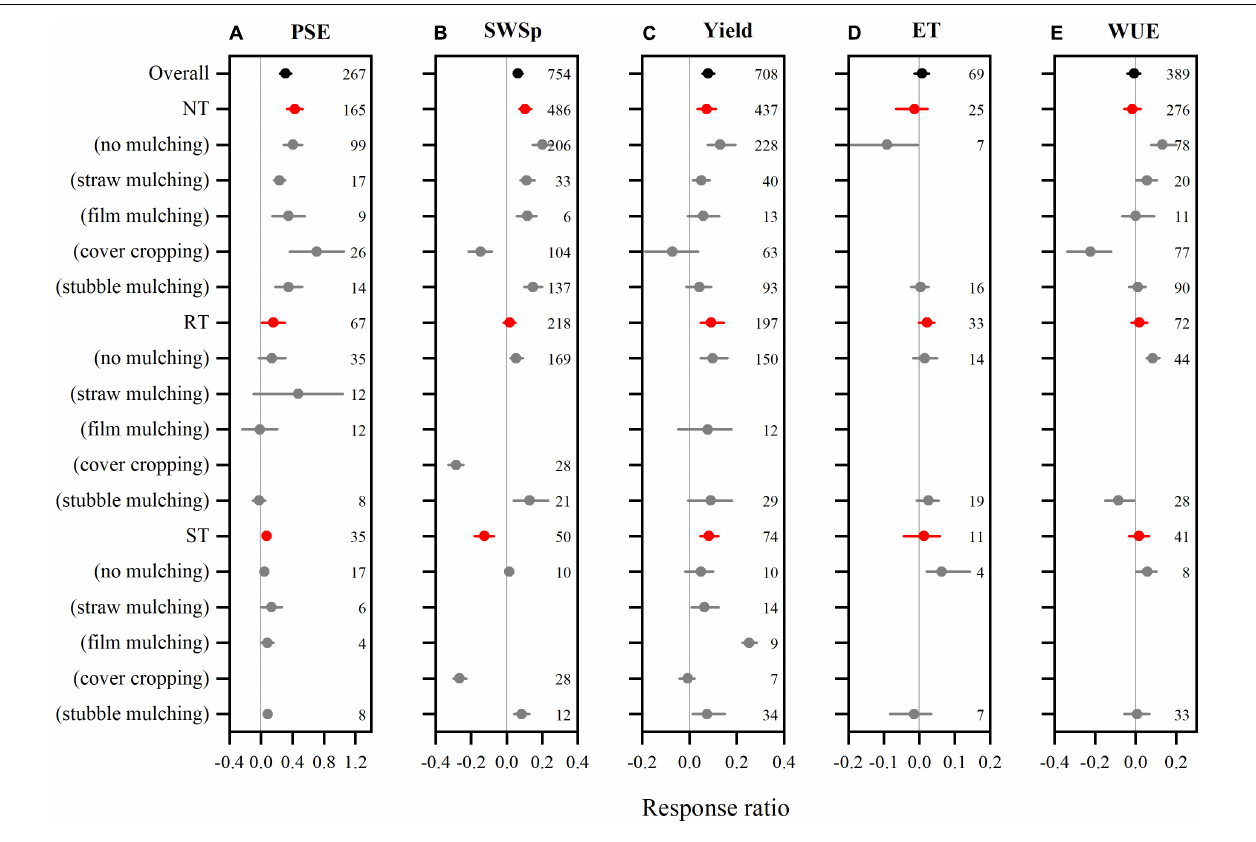
FIGURE 2 | The mean response ratios of precipitation storage efficiency (PSE, A ), soil water storage at wheat planting (SWSp, B ), winter wheat grain yield (C) , evapotranspiration (ET, D ), and water use efficiency (WUE, E ) to conservation tillage methods during fallow period compared to conventional tillage (CT) and their interactions with fallow mulching practices. The horizontal line represents the bootstrapped 95% confidence interval. Conservation tillage methods are no tillage (NT), reduced tillage (RT), subsoil tillage (ST). The reference line (RR = 0) specifies no variation between conservation tillage and conventional tillage. Numbers accompanying the bootstrapped 95% confidence intervals designate the number of observations for